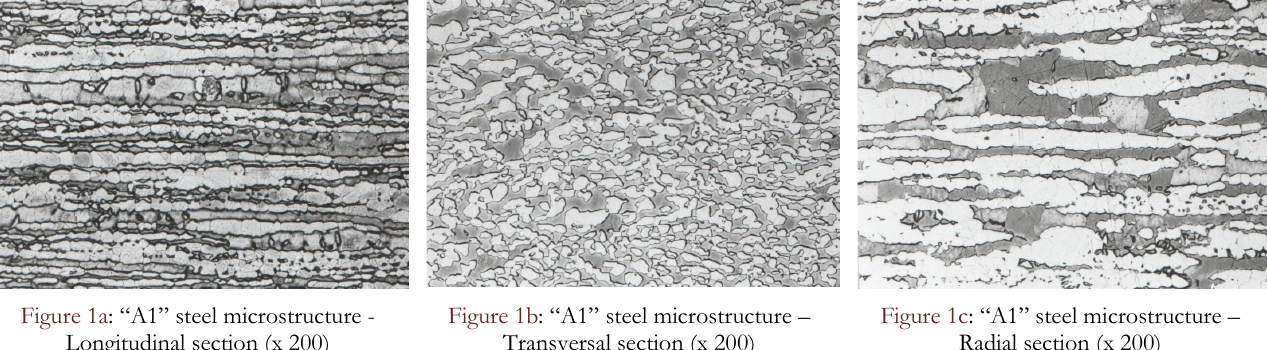
Figure 1a: “A1” steel microstructure - Longitudinal section (x 200)